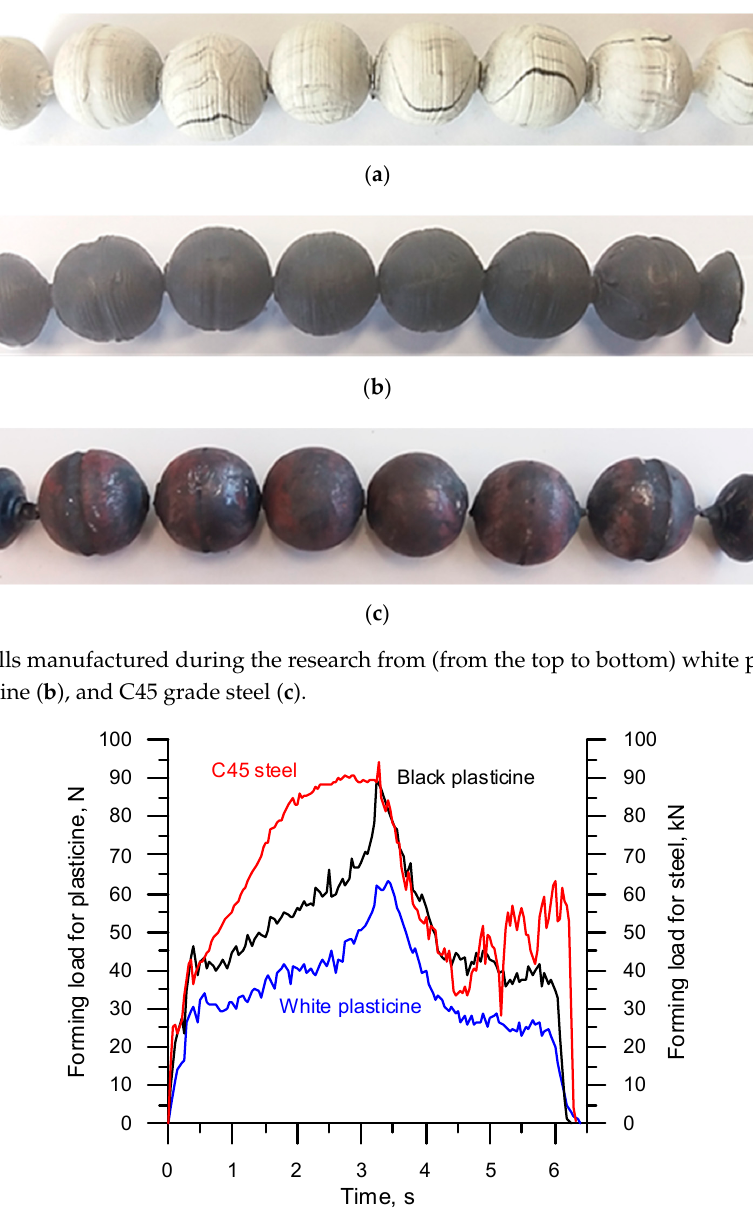
Figure 10. Distribution of the force moving the wedge tool, registered during cross rolling of balls. For a quantitative comparison, maximum force, F max , was chosen. As far as rolling of steel balls from a 1000 °C billet is concerned, the maximum force equaled 94.37 kN. In order to estimate the F max